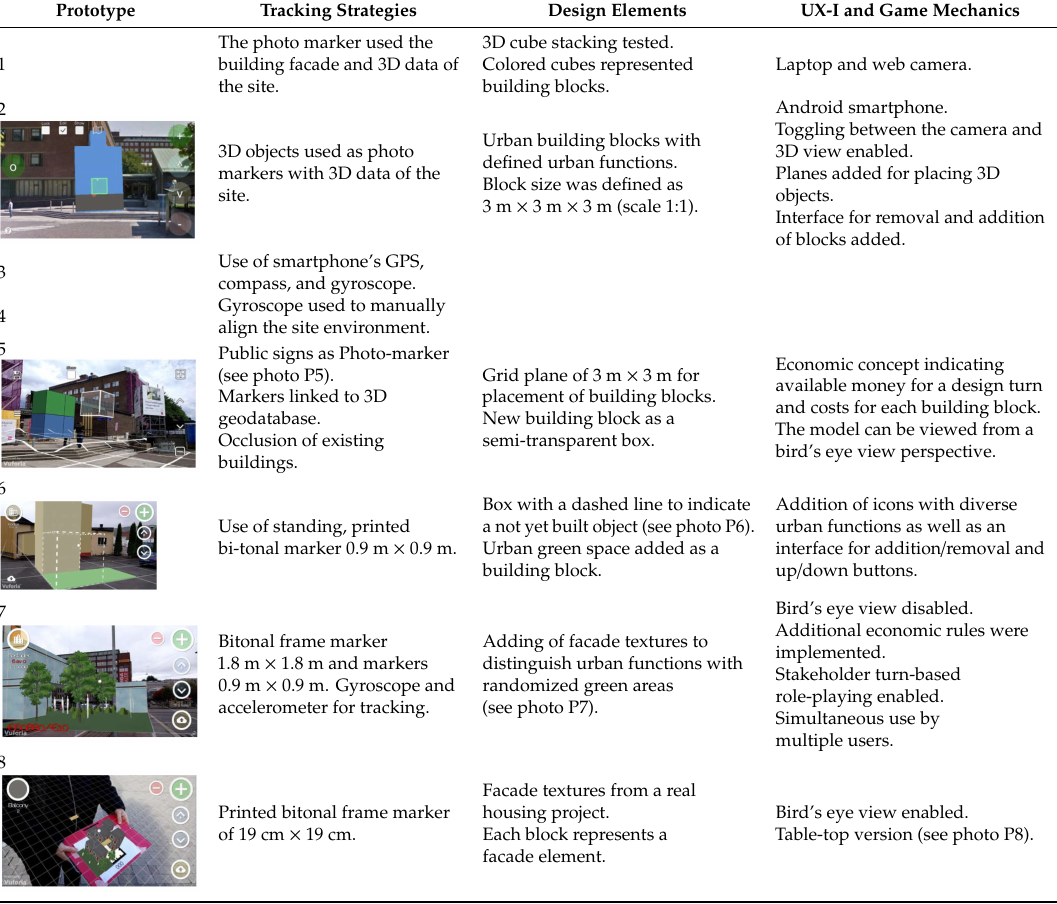
Table 1. Implementation of design criteria and the iteration in each